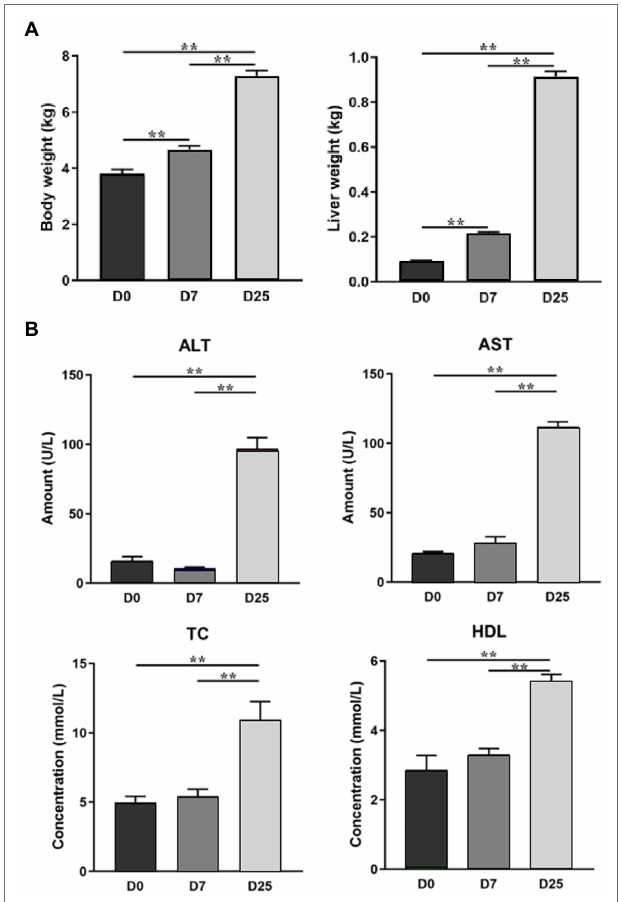
FIGURE 1 | The effects of overfeeding on the body weight and liver weight of Landes geese (A) and the serum biochemical parameters of Landes geese (B) (Gong et al., 2020). Asterisks (**) represent significant differences with p <